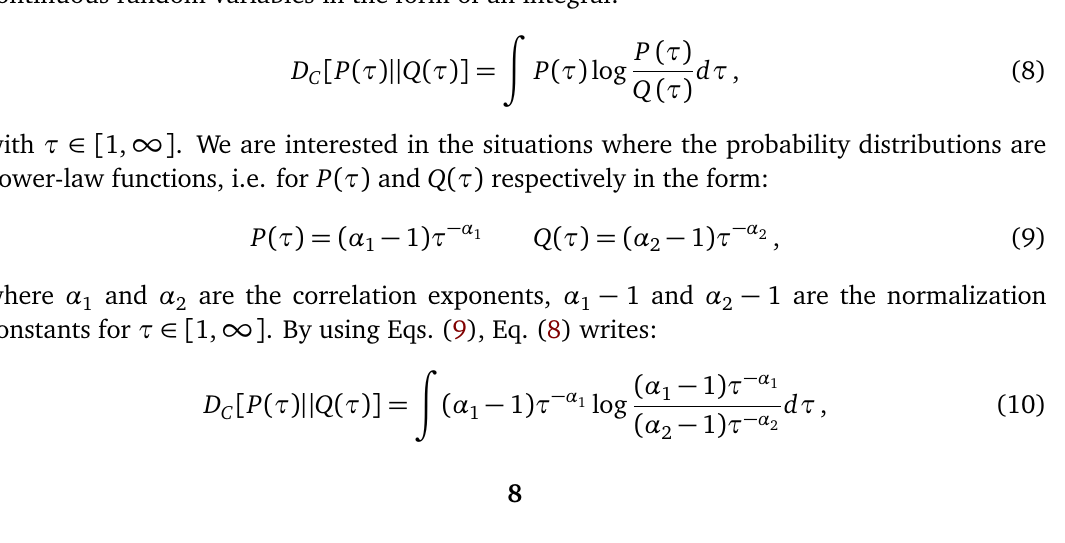
1 ranging between 1 [ P || P ] = 0 obtained C